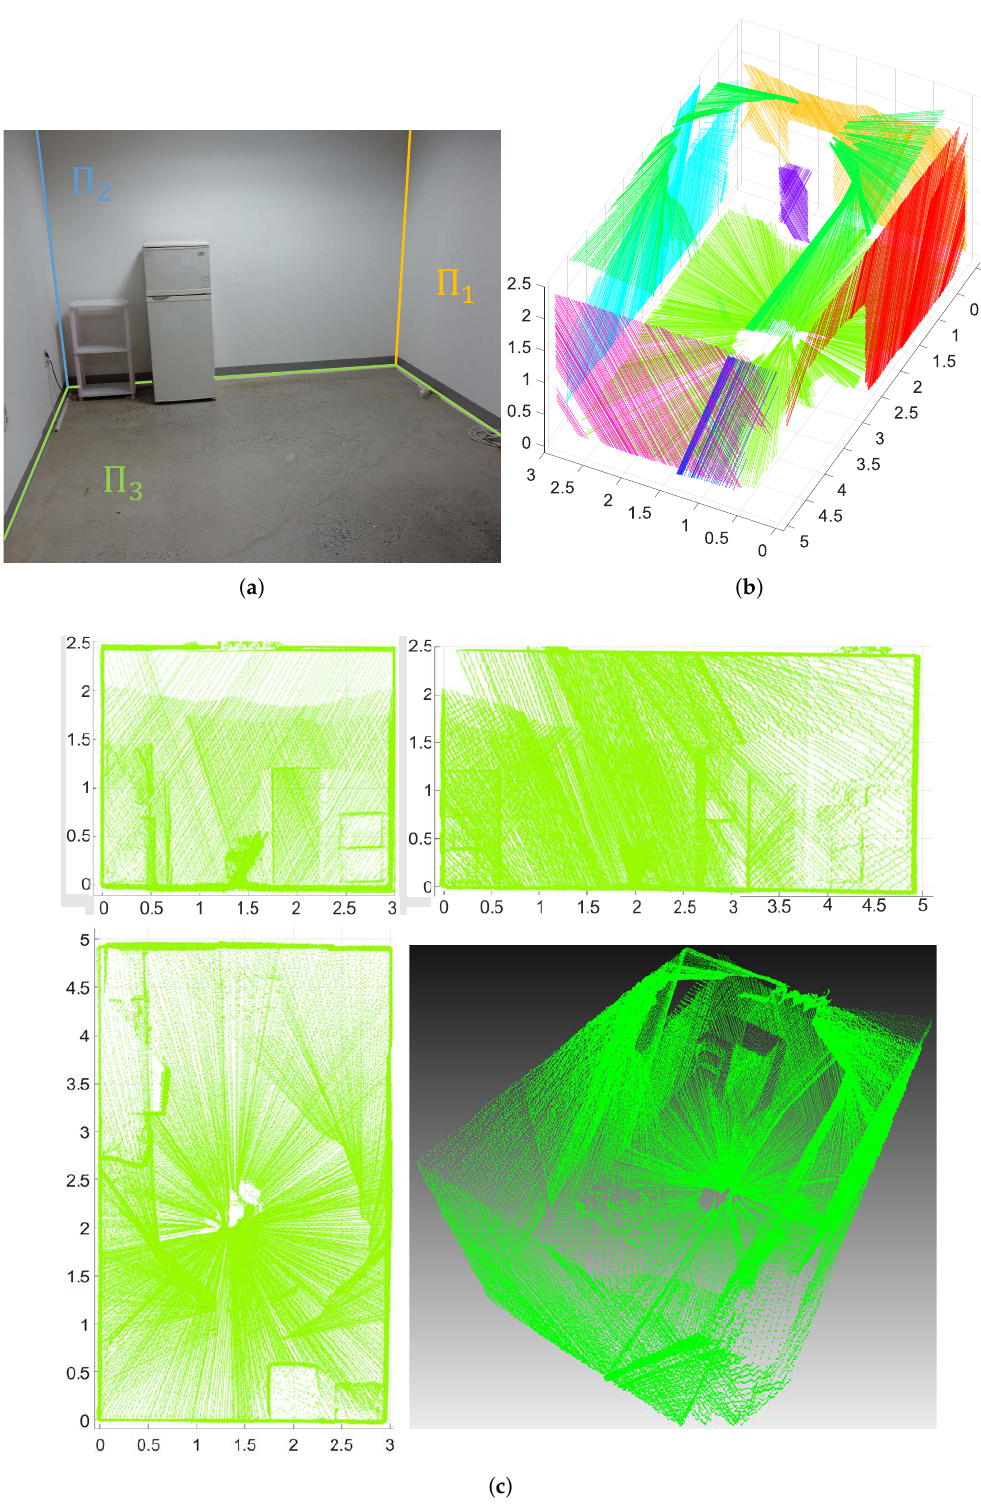
Figure 8. 3D reconstruction results of the proposed method: ( a ) real environment ( b ) scanned line segments displayed in colors of corresponding planes; and ( c ) 3D reconstruction results by accumulating scan